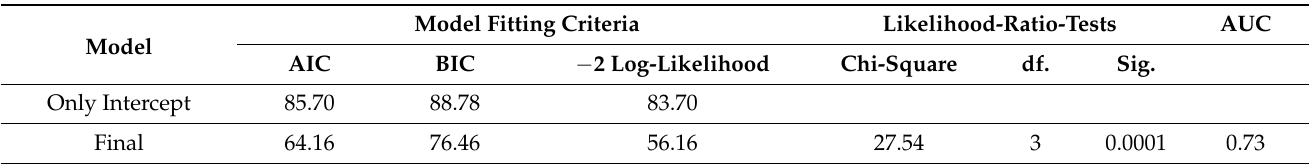
Table 5. Model fitting information of multivariate logistic regression analysis of vaccination decision- making in parents with children between 12 to 23 months ( n =